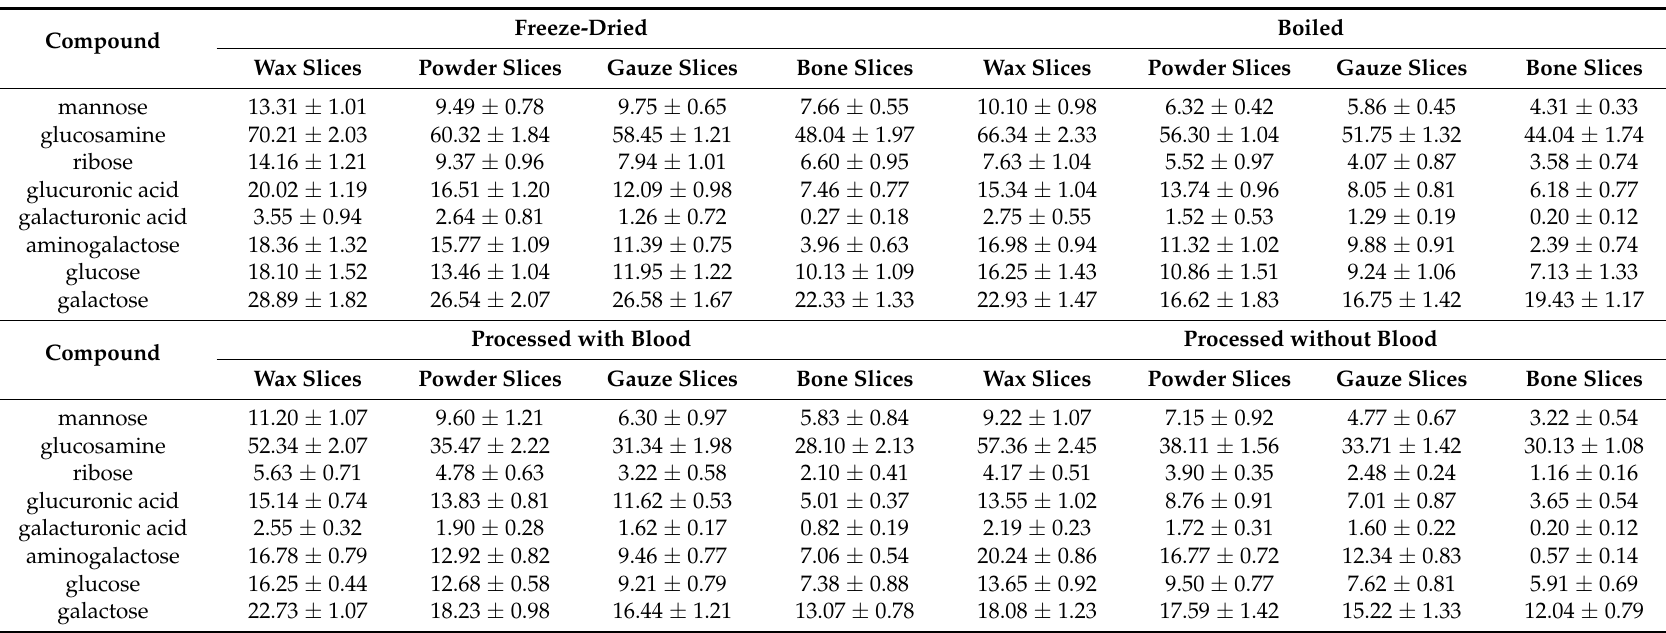
Table 3. Eight monosaccharides contents in processed velvet antler, expressed per mg/kg ( x ± SD, n = 3).